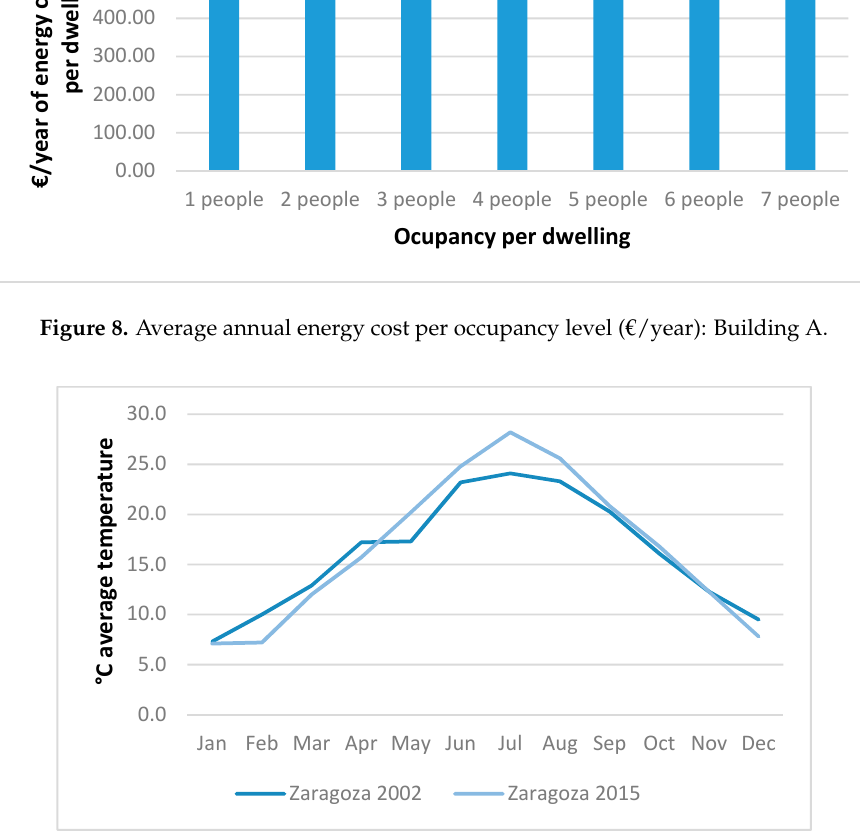
Figure 9. Average daily temperature in Zaragoza (°C) in the reference year 2002 and in year 2015.